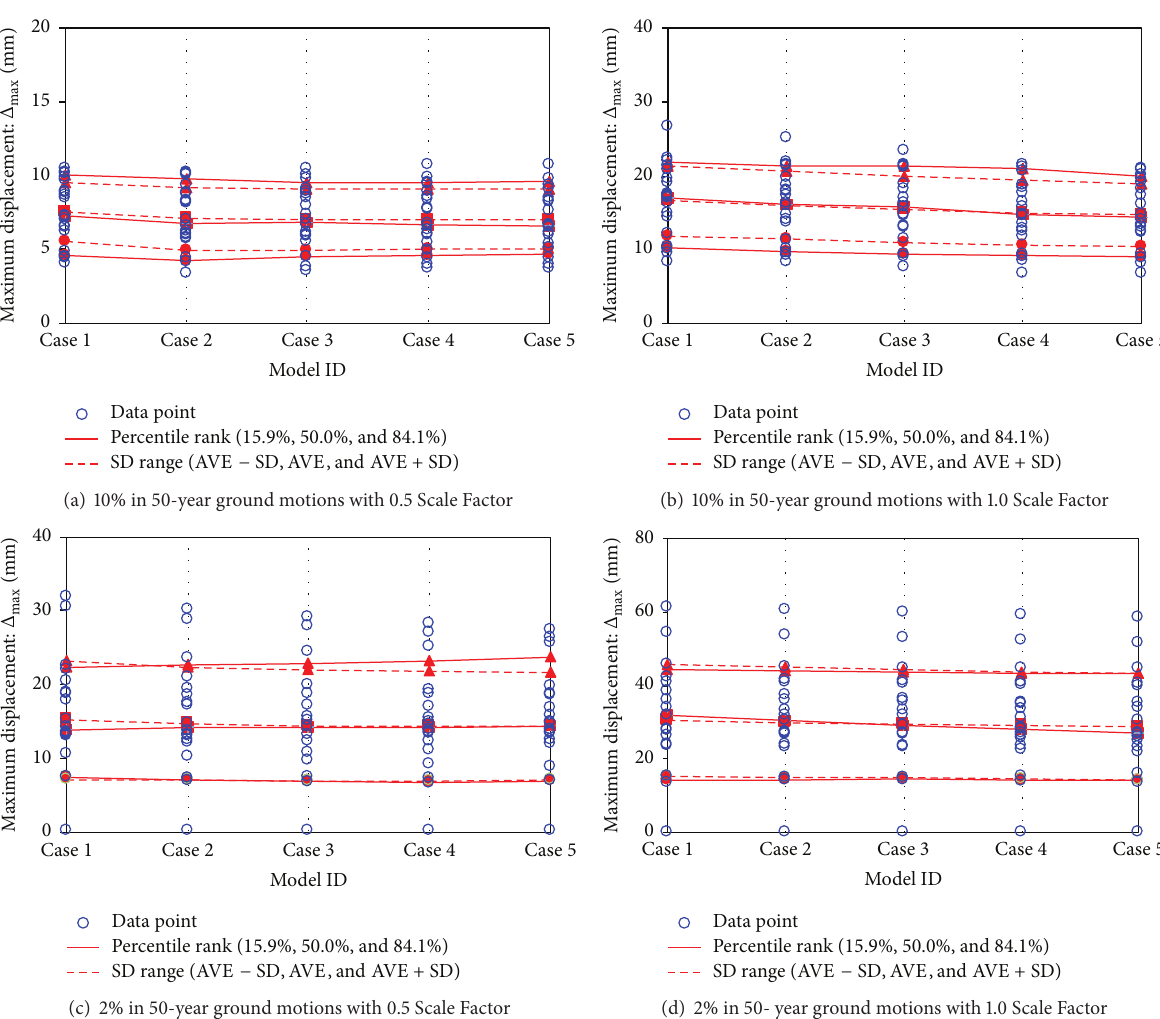
statistical values for the maximum brace forces as compared to other model cases. Overall, the statistical lines steadily ascend according to the shifting from Case 1 model to Case 5 model. The largest average and standard deviation values are also found at the SFDB models subjected to 2% in 50- year ground motions with 1.0 SF. The residual displacement ( Δ res ) for individual SFDB models under 40 ground motions with different SFs is presented in Figure 14. The distribution of obtaining residual displacement data similarly ranges from 0 to 2 mm at all graphs, irrespective of hazard levels and SFs. This implies that the SFDB models can generate small residual displacement even under strong seismic loading.